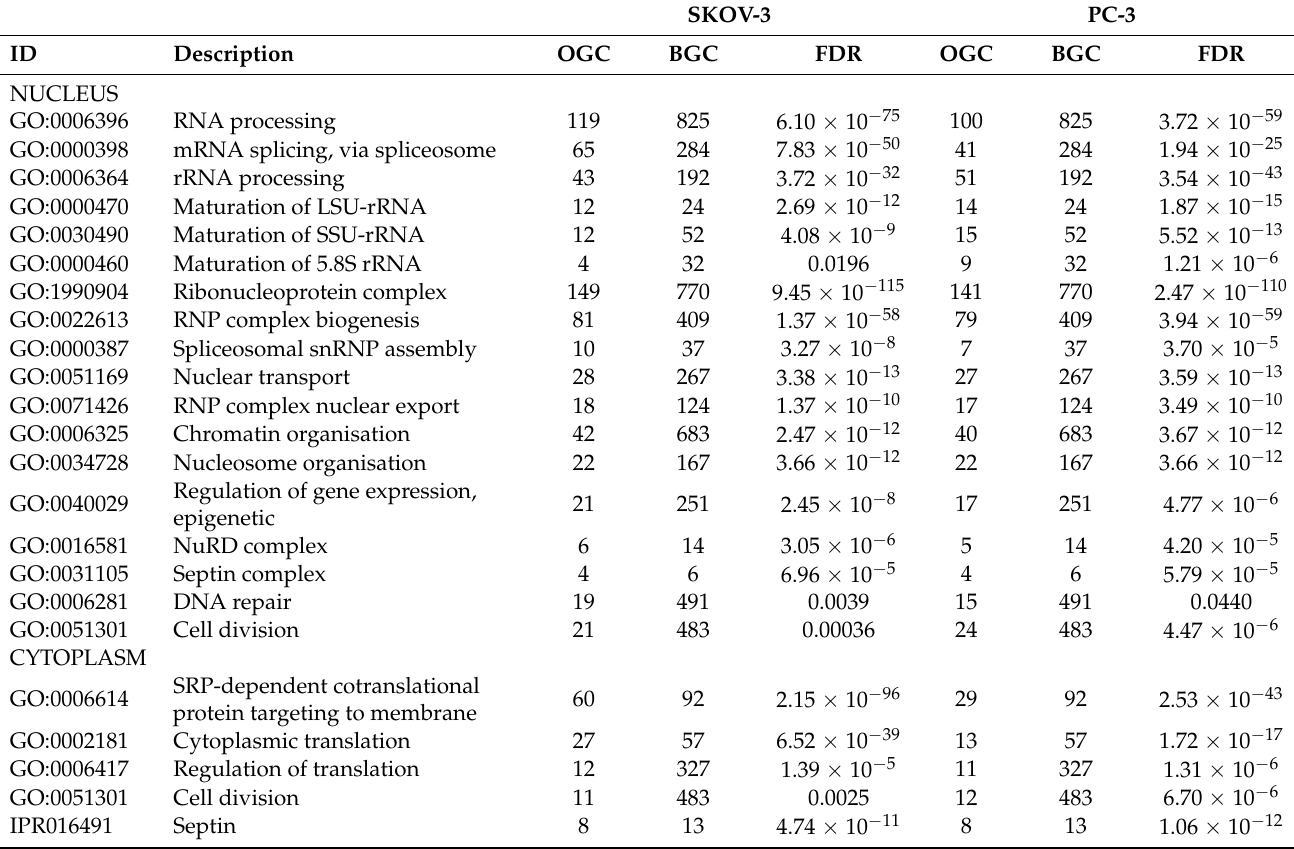
Table 2. GO term enrichment analysis of the nuclear and cytoplasmic HMGB1-interactomes in SKOV-3 and PC-3 cells. (OGC, observed gene count; BCG, background gene count; FDR, false discovery